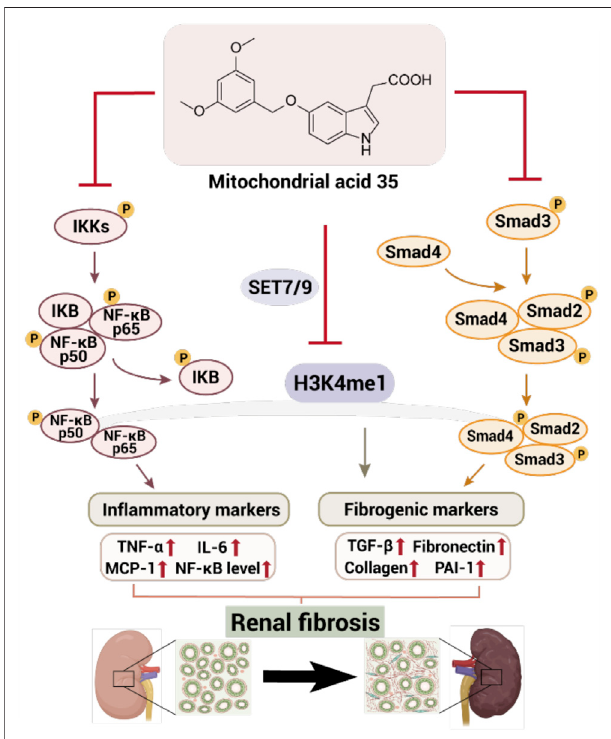
FIGURE5| Mitochondrialacid35inhibitsTNF- α andTNF- β 1pathwayto ameliorate renal fi brosis.